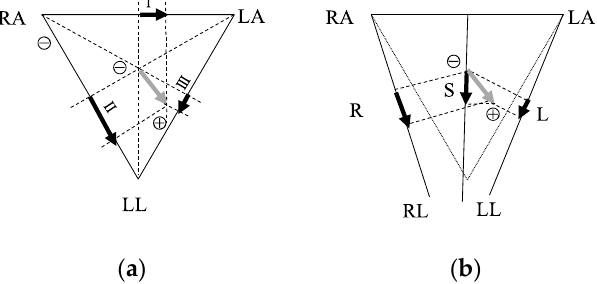
Figure 3. ECG vector projection onto the medical ECG limb leads ( a ) and the cECG. Grey arrows are the ECG vectors. Black arrows in (a) are the projections in leads I, II, and III; the black arrows in ( b ) are the projections of L, R, and S sleeping positions.